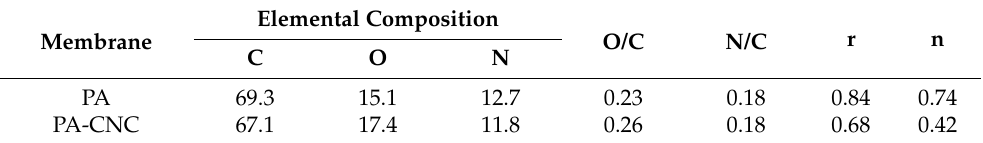
Table 2. XPS analysis for both the PA and PA-CNC membranes.